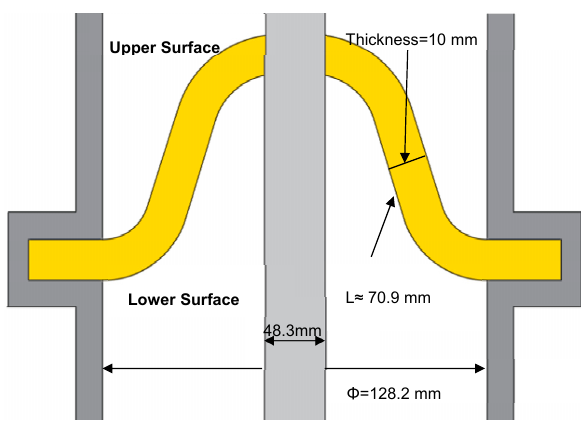
Figure 1. Initial profile of the reduced-scale spacer model.